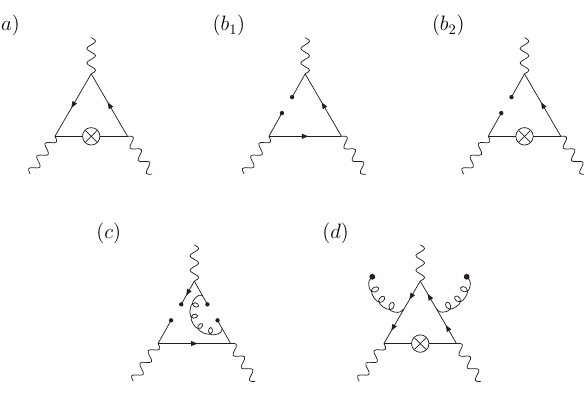
Figure 2. Various contributions to the OPE. The leading order contribution is ( a ) the quark loop. The crossed vertex indicates the interaction of the external field on the perturbative quark line. At next-to leading order the non-perturbative condensates ( b 1 , 2 ) appear, namely (cid:104) q σ µν q (cid:105) , induced by F µν , and (cid:104) qq (cid:105) . At next-to-next-to leading order diagram ( c ) is a four-quark operator with condensate (cid:104) q Γ 1 qq Γ 2 q (cid:105) , and diagram ( d ) contains the gluon condensate (cid:104) α s GG (cid:105)